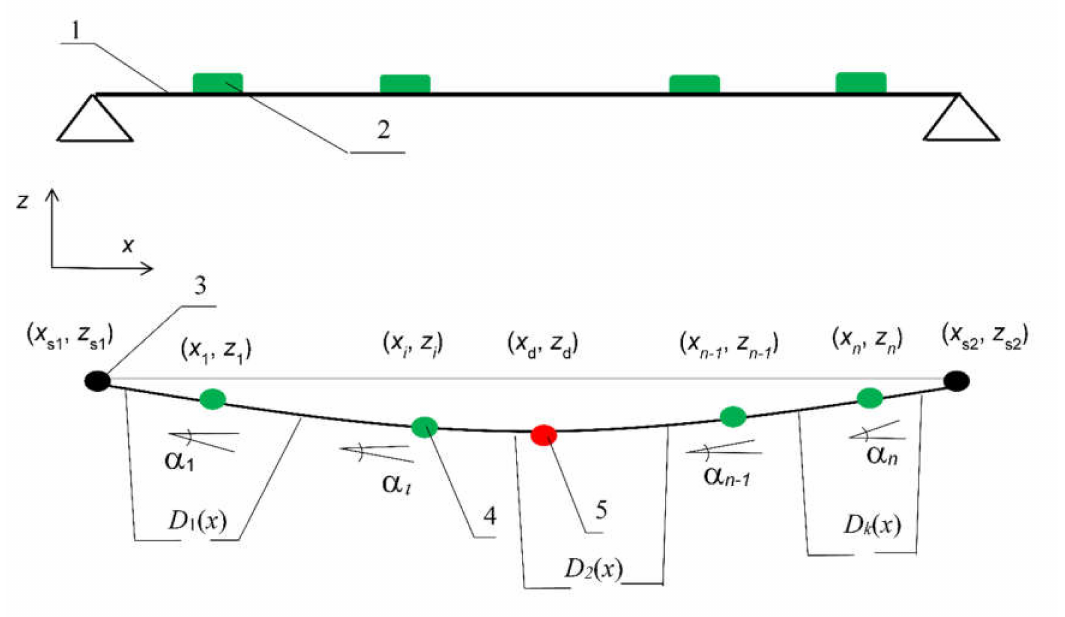
Figure 2. Diagram of the structure deflection line outlining: Upper—the arrangement of inclinometers ( 1 ) along the monitored span; ( 2 ) lower—the spline curve outlined, where: ( 3 ) Support point, ( 4 ) point of theinclinometer’slocation, ( 5 )pointofthedisplacementexamination; ( x s1 , z s1 )and( x i , z i )respectivelythe coordinates of the span support points and inclinometers; a i , inclinometer readings; D k ( x ), spline